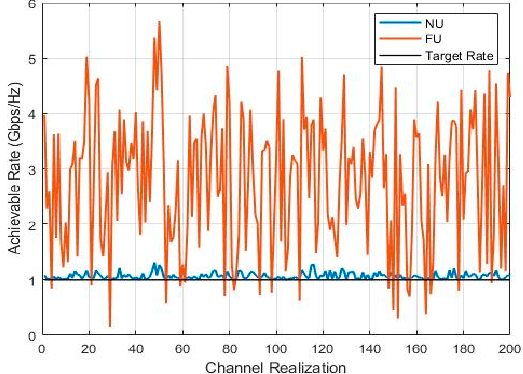
Figure 9. Instantaneous rate vs. channel realization.